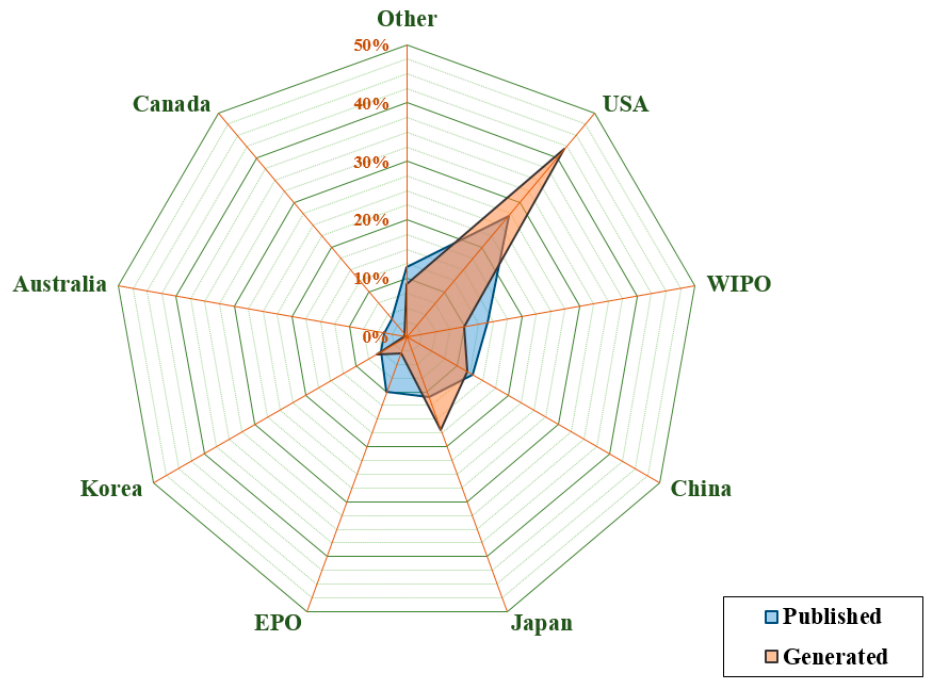
Figure 2. Patents of CPC Y02C 10/10 as a function of their provenance.